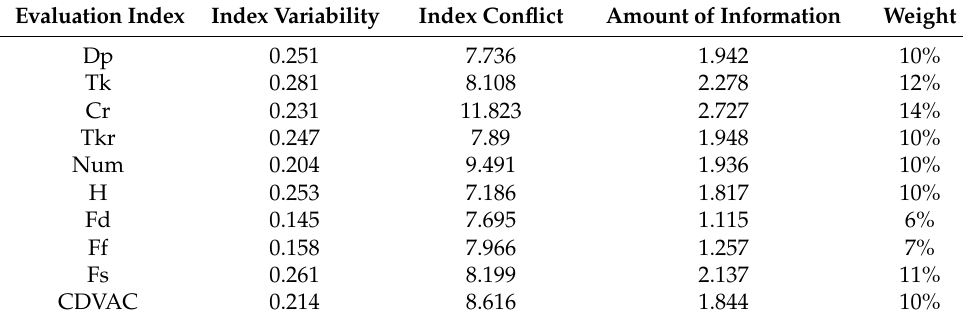
Table 3. Weight of each evaluation index based on the CRITIC method.